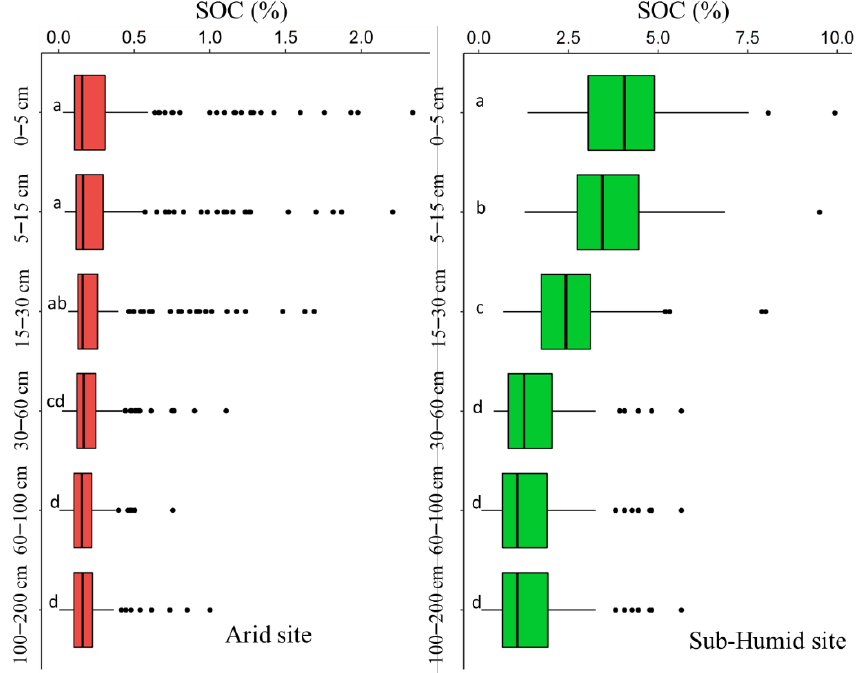
Figure 4. Box plot of SOC content at six standard depths at the two regions. Different letters (a:d) indicate a significant difference of mean SOC content at the 0.05 level.